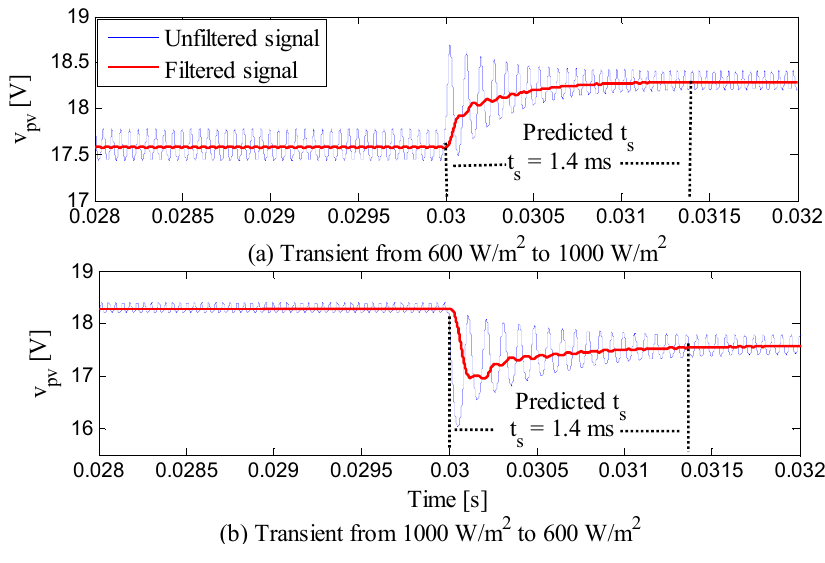
Figure 11. Settling-time estimation.